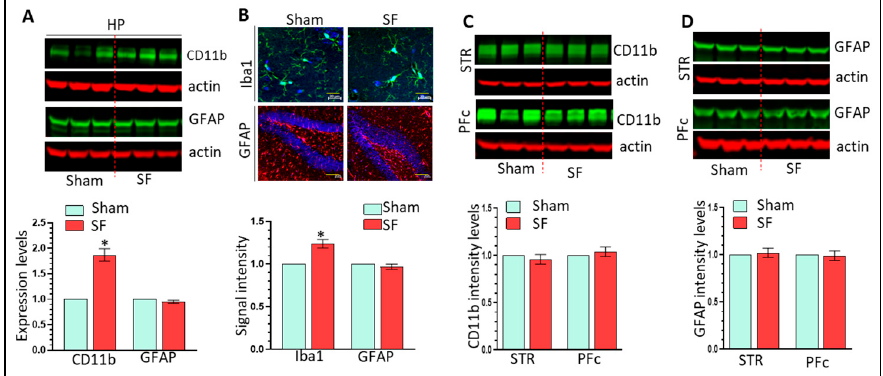
Figure 2. Three-weeks of SF activates microglia but not astrocytes in the brain. ( A ): three-weeks of SF increases CD11 levels but not GFAP levels in the HP (n = 6, * p < 0.05); ( B ): three-weeks of SF increases Iba1 signal intensity but not GFAP levels in the HP (n = 6, * p < 0.05, scale bar = 20 µ); ( C , D